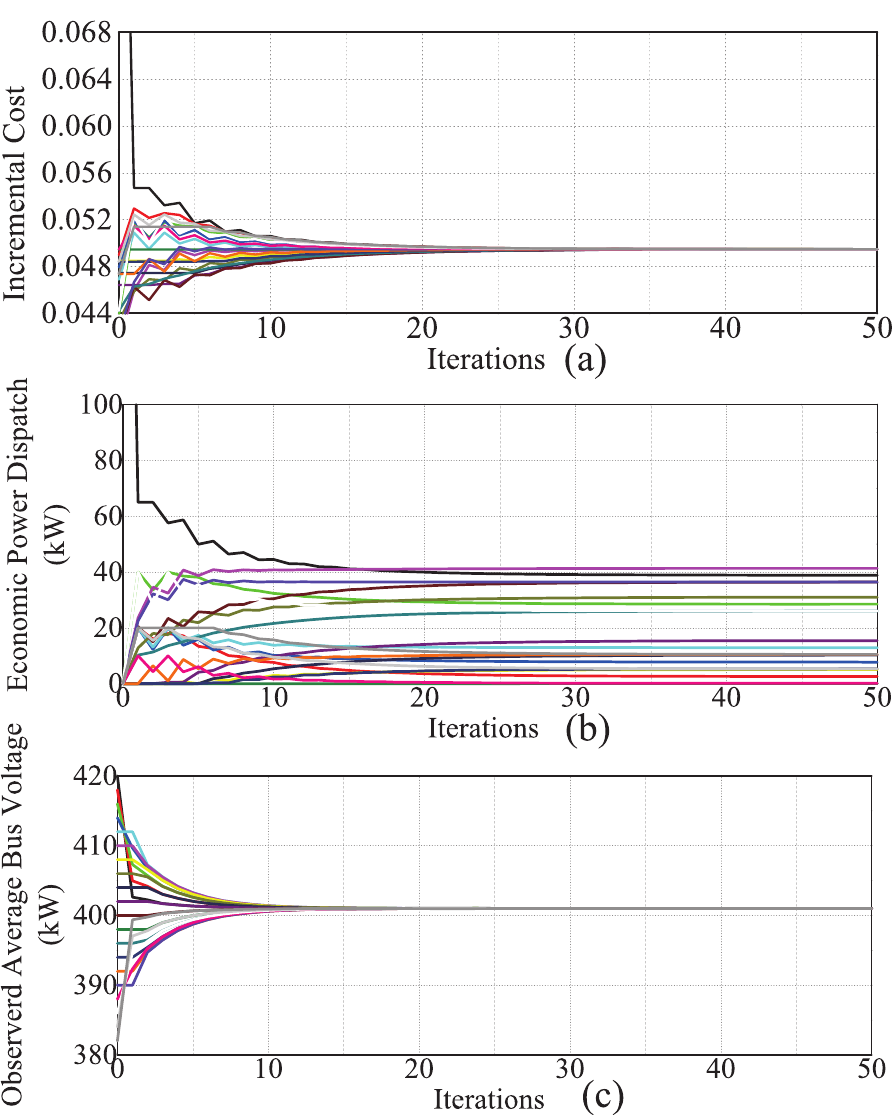
Figure 7. Convergence test of the EPD and ABVO algorithms for a larger DC microgrid with 20 DGs. ( a ) Incremental cost of the DGs in each iteration; ( b ) EPD of the DGs in each iteration; ( c ) observed average bus voltage of the DGs in each